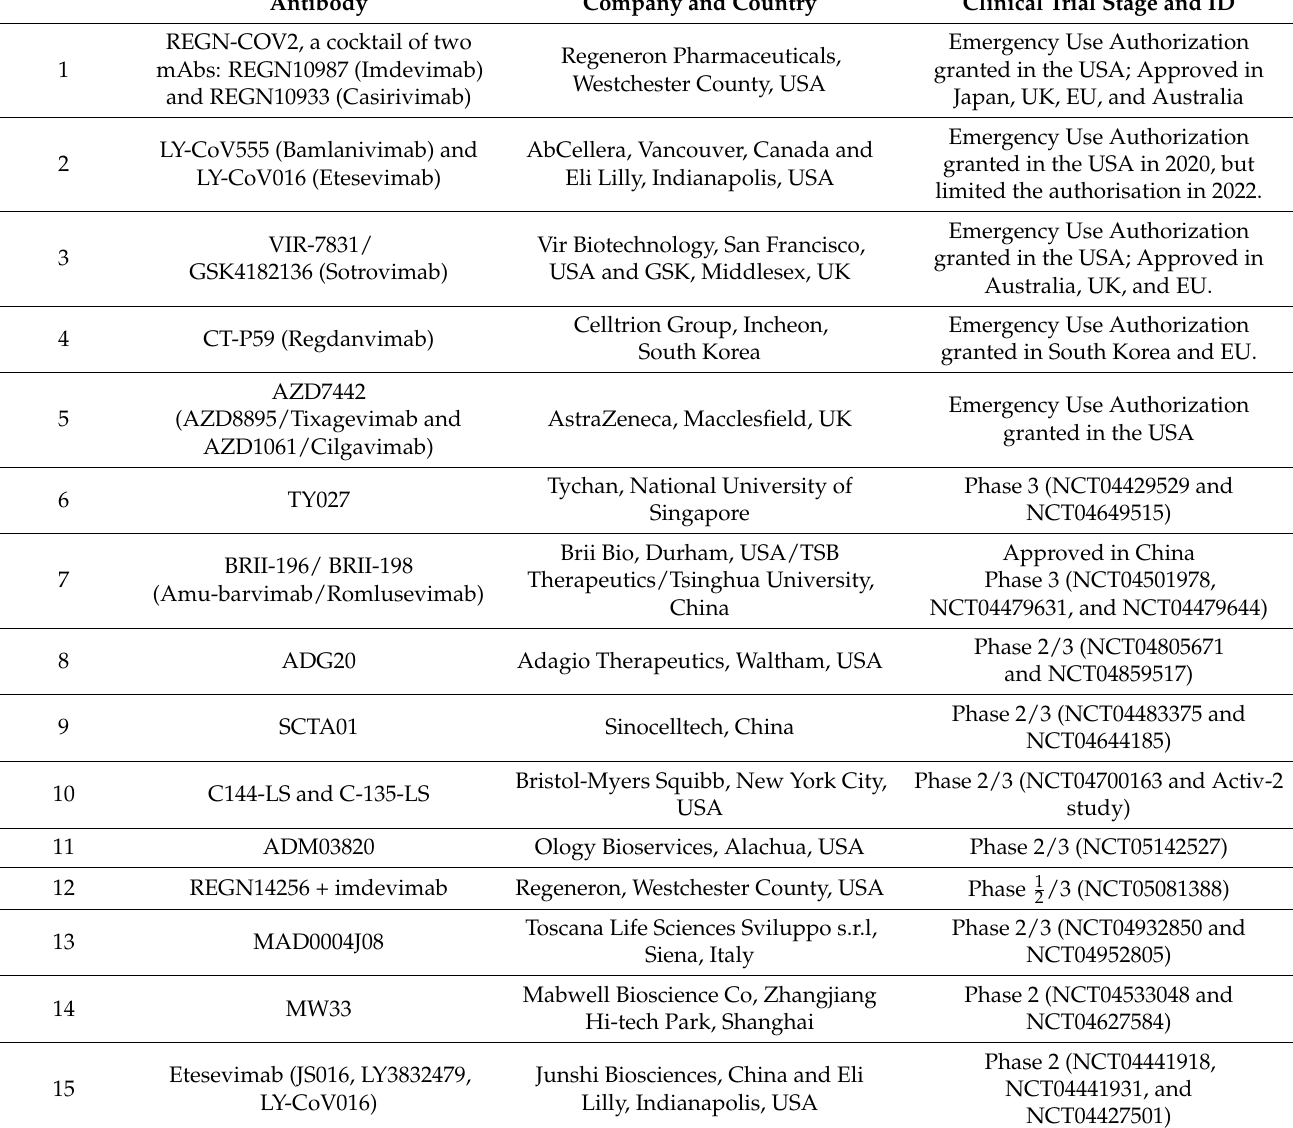
(Table 1). On 9 November 2020, the U.S. Food and Drug Administration (FDA) issued an emergency use authorisation for Bamlanivimab for the treatment of mild-to-moderate COVID-19 in adult and paediatric patients [53]. Regeneron REGN-COV2 (Casirivimab and Imdevimab) was also approved by the FDA (on 21st November 2020) in adults with mild-to-moderate COVID-19 who are at high risk for poor outcomes [53]. However, in January 2022, the FDA has limited the use of Bamlanivimab and Etesevimab, due to the Omicron Variant, to only when the patient is likely to have been infected with or exposed to a variant that is susceptible to these two antibodies [1]. Table 1. List of antibodies currently in clinical development. Data were extracted from National Insti- tutes of Health databank (https://clinicaltrials.gov/; accessed on 20 April 2022), and the Antibody Society (https://www.antibodysociety.org/covid-19-biologics-tracker/; accessed on 10 May 2022). Company and Country Clinical Trial Stage and